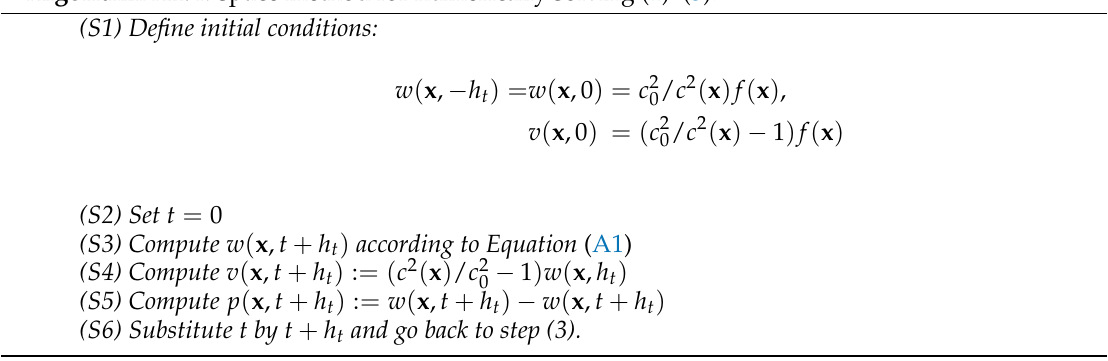
Algorithm A1: k-space method for numerically solving